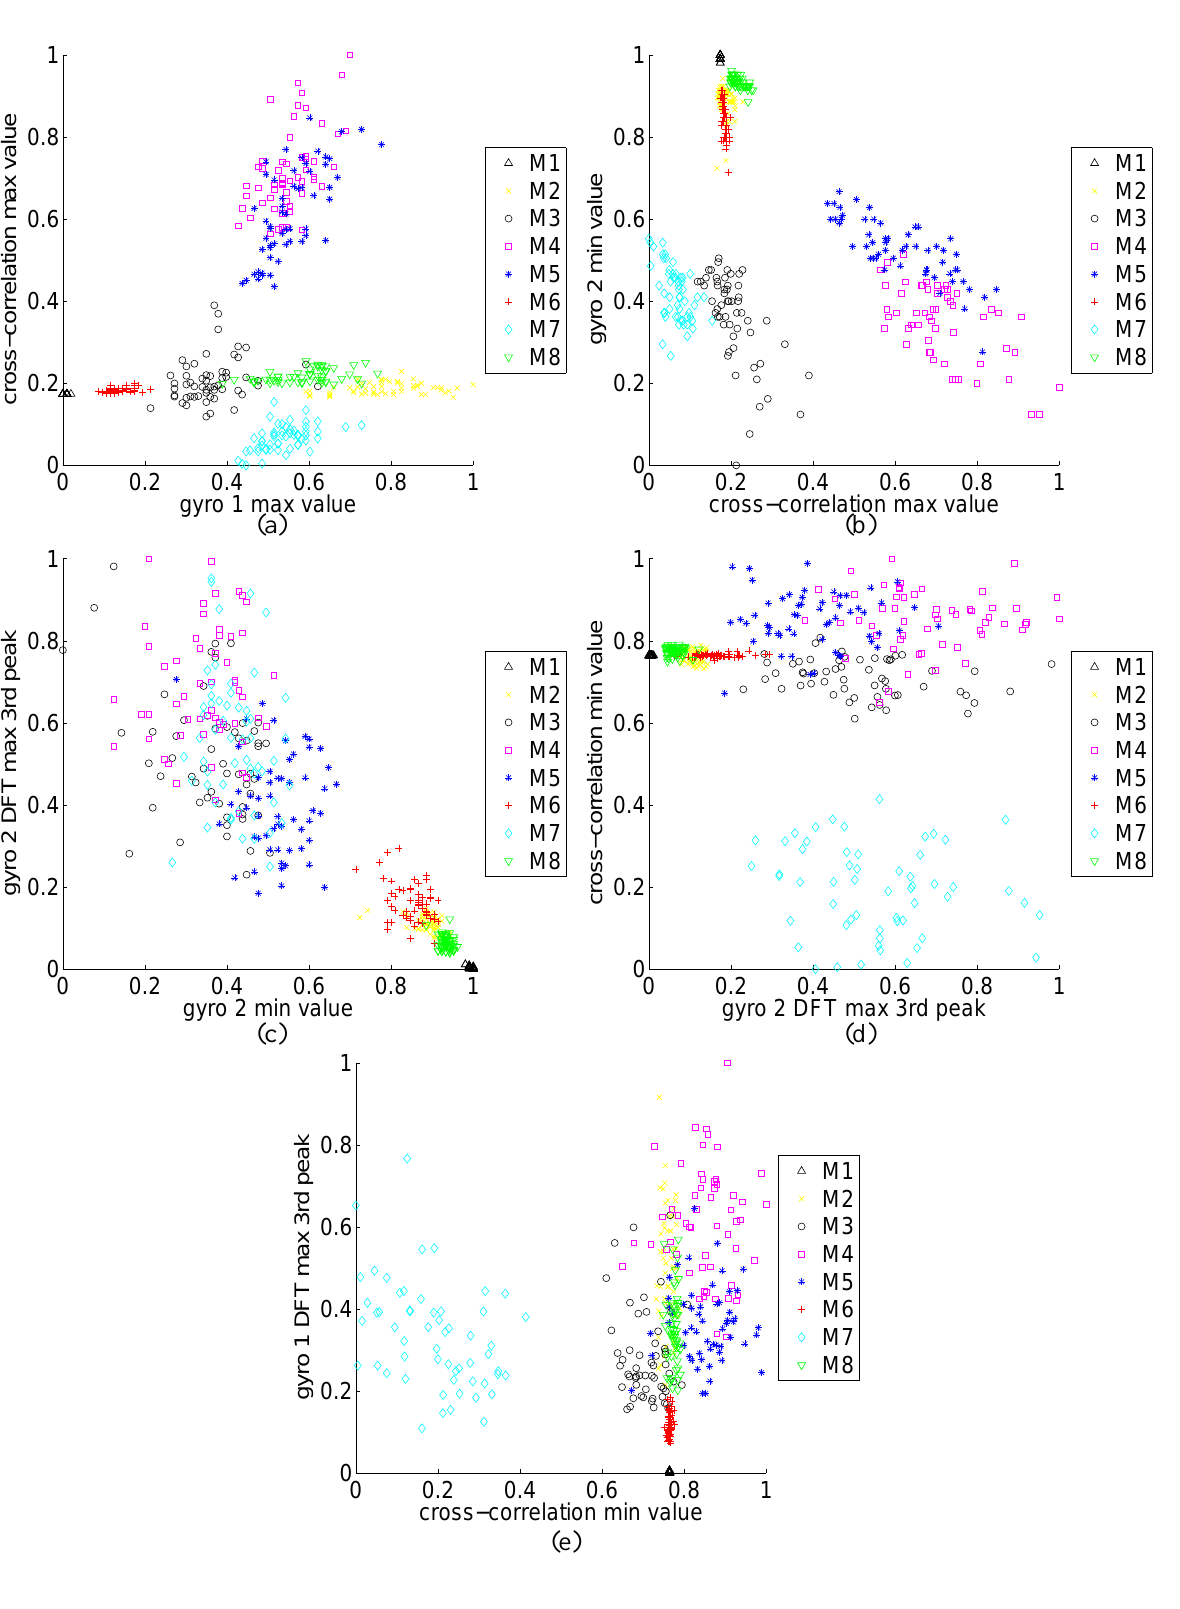
Figure 6. Scatter plots of the features selected by